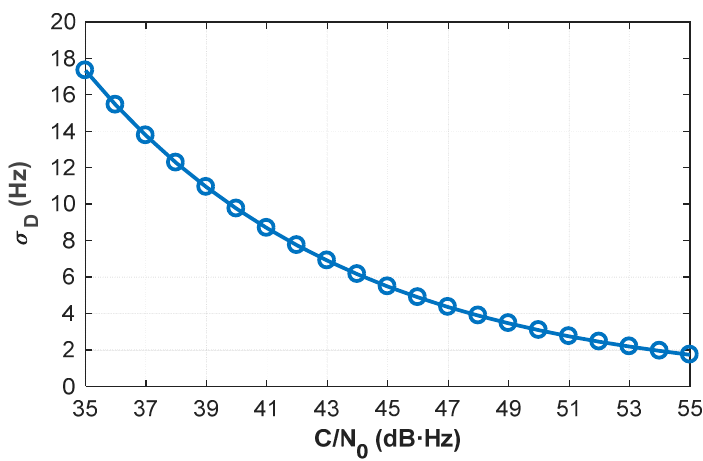
Figure 4. Theoretical Doppler jitters as a function of different C / N 0 values.